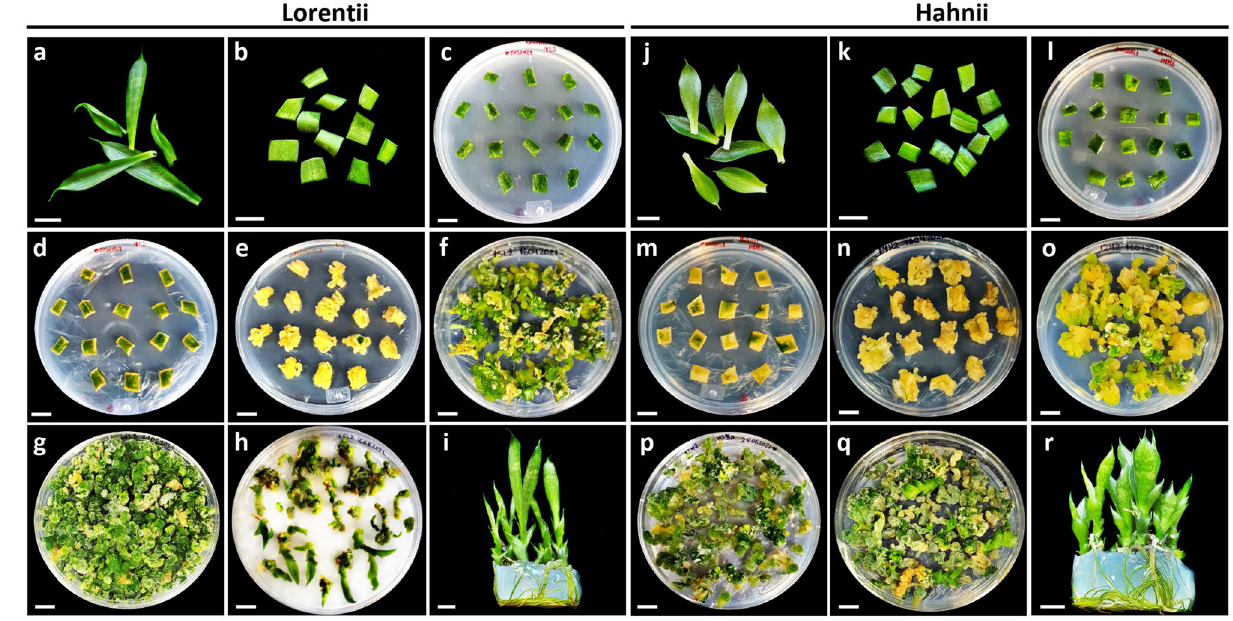
Figure 3. Overview of different steps for indirect de novo shoot production for cvs Lorentti and Hahnii of Sansevieria trifasciata . Establishment of ( a , b , c , j , k , l ) leaf-segment-derived culture, ( d , e , m , n ) primary calli, ( f , g , o , p ) organogenic calli, ( h , q ) shoot production and ( i , r ) shoot rooting.